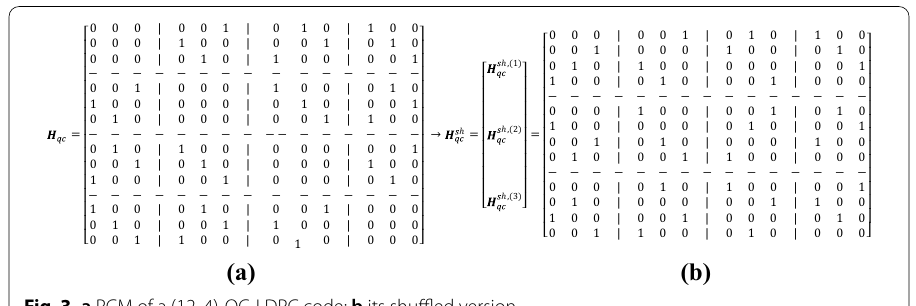
Fig. 3 a PCM of a (12, 4)-QC-LDPC code; b its shuffled